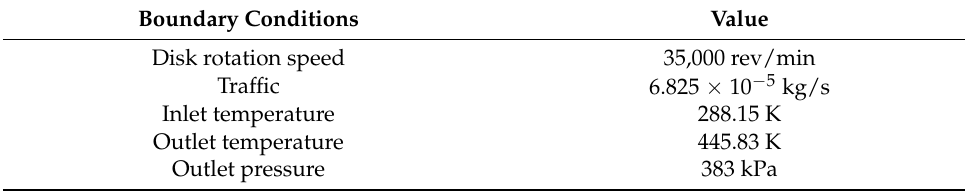
Table 2. Material properties of Ti6Al4V